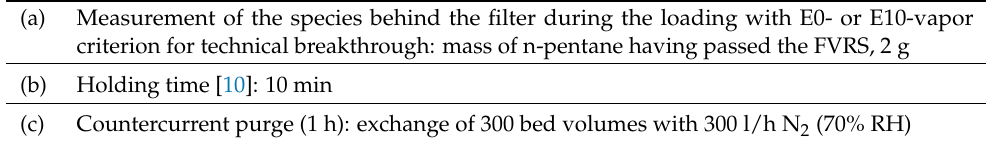
Table 1. Procedure of the experiments with humid N 2 as purge gas at 24 ◦